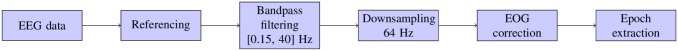
Processing and classification pipeline for the single-user and the collaborative BCIs.